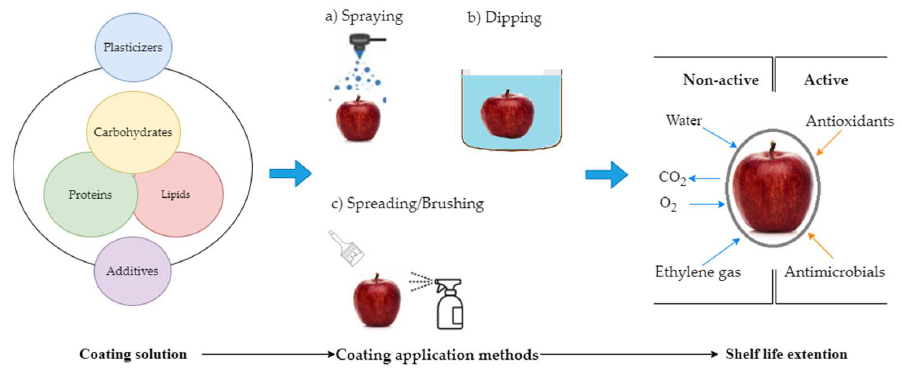
Figure 1. Main components of edible coatings and application methods on fruits.